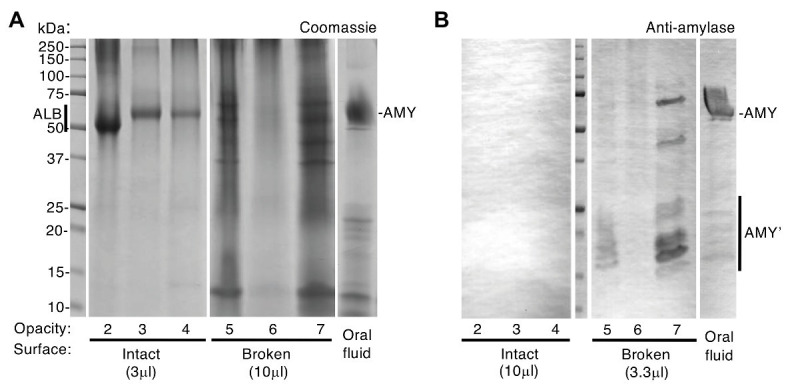
Intact opacities are impermeable to amylase, unlike broken opacities. Chalky enamel harvested from three opacities with intact surfaces and three with visibly broken surfaces (opacities 2–4 and 5–7, respectively) was subjected to SDS-PAGE and amylase immunoblotting with phosphatase detection as indicated. Differential sample loads were used for semi-quantification as indicated, and oral fluid was analysed in parallel. (A) Coomassie Blue staining revealed a single major band [albumin (ALB)] in intact opacities that had been surface-cleaned, consistent with Figure 1. In contrast, broken opacities exhibited a complex banding pattern overlapping that of oral fluid, in which amylase (AMY) predominated as expected. (B) Immunoblotting revealed amylase (AMY) in broken opacities but not in intact opacities, despite 3-fold up-loading of the latter as indicated. Amylase fragments (AMY’) were more prominent in broken enamel than in oral fluid. Equal amounts of oral fluid (10 μl equivalent) were loaded in (A) and (B). This figure was composited from (A) two Coomassie-stained gels, and (B) a single immunoblot made in parallel.